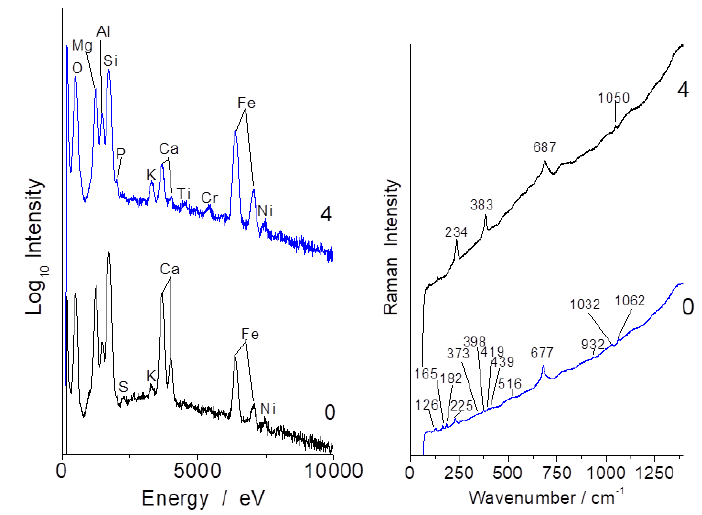
Figure 6. Representative EDS ( left ) and Raman ( right ) spectra recorded on spots 0 and 4 of sample b (see Figure 1).